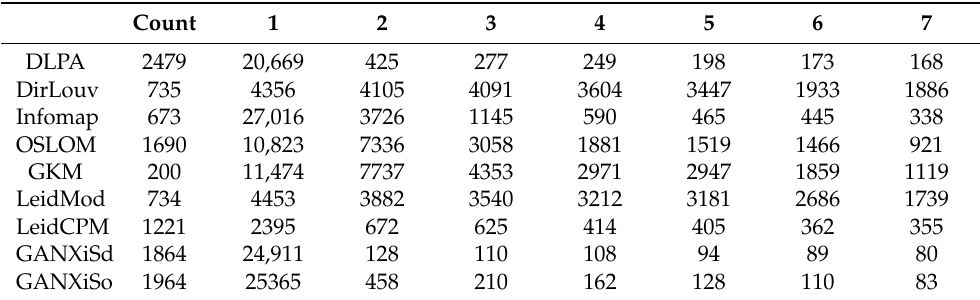
Table 4. The number of communities obtained on the Cologne dataset and the value of the seven largest of them for each